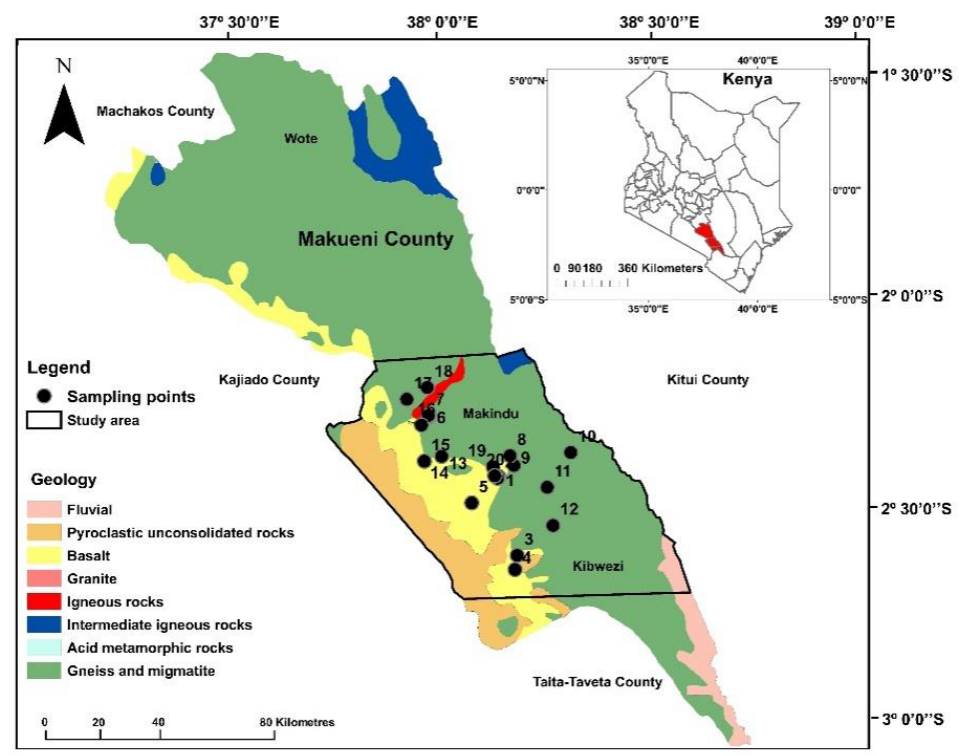
Figure 1. Map of Makueni County showing the geology and location of the sampling area around Makindu and Kibwezi. Modified from Ng’ang’a et al. [17]. About 36% of the population in the county have access to improved water sources that include protected springs and wells, boreholes, and piped water, while the rest rely on dams, rivers and streams, unprotected wells, and water vendors [16]. To address the water shortfall, the county government and other local non-government organizations (NGOs) have provided alternative water sources including drilling and provision of community boreholes and shallow wells, construction of sand dams, and establishment of irrigation schemes along permanent rivers [2,18]. Most of the population in Makindu and Kibwezi towns have access to piped water, which is sourced from the Umami spring and provided by the Tanathi Water Services Board, a government organisation. The other areas are more remote and rely on groundwater